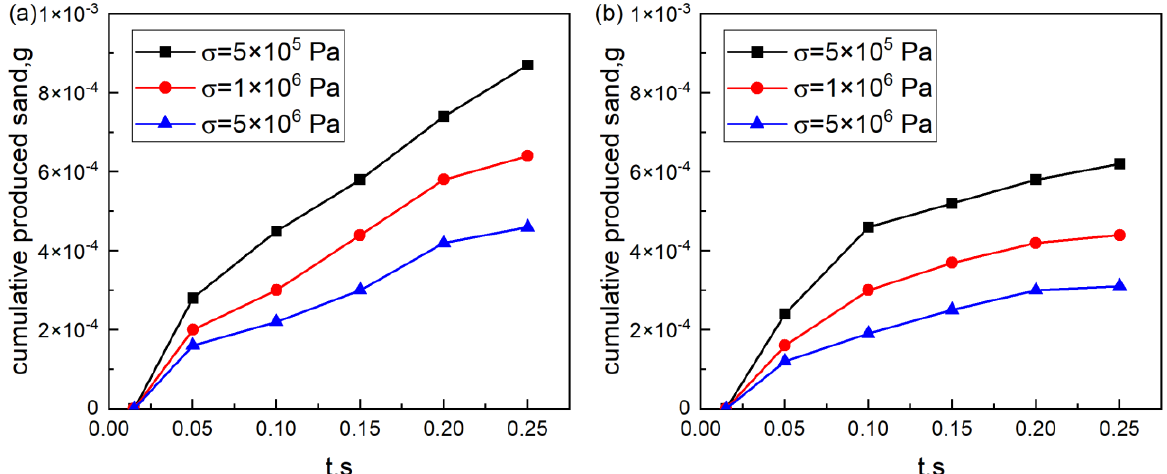
Figure 12. Cumulative weight of produced sand at different cementation strength ( a ) confining pres- sure equals 0.8 MPa ( b ) confining pressure equals 3 MPa. pres-sure equals 0.8 MPa ( b ) confining pressure equals 3